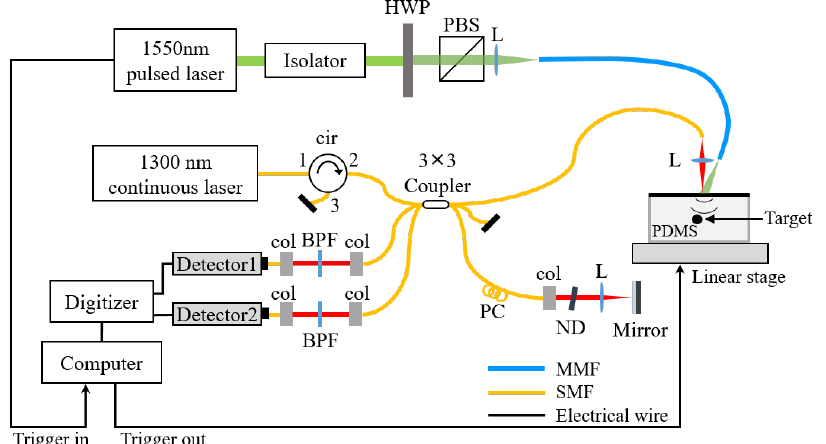
Figure 5. The LUS system implemented with a 3 × 3 optical interferometer. cir, circulator; PC, polarization controller; col, collimator; ND, neutral density filter; L, lens; BPF, band pass filter; HWP, half-wave plate; PBS, polarization beam splitter.